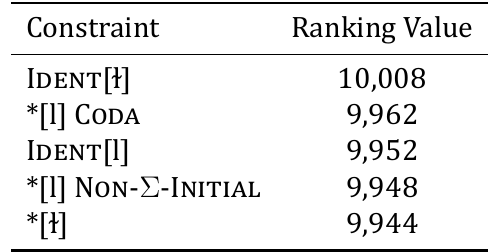
Table 12: Constraint ranking values at the word level